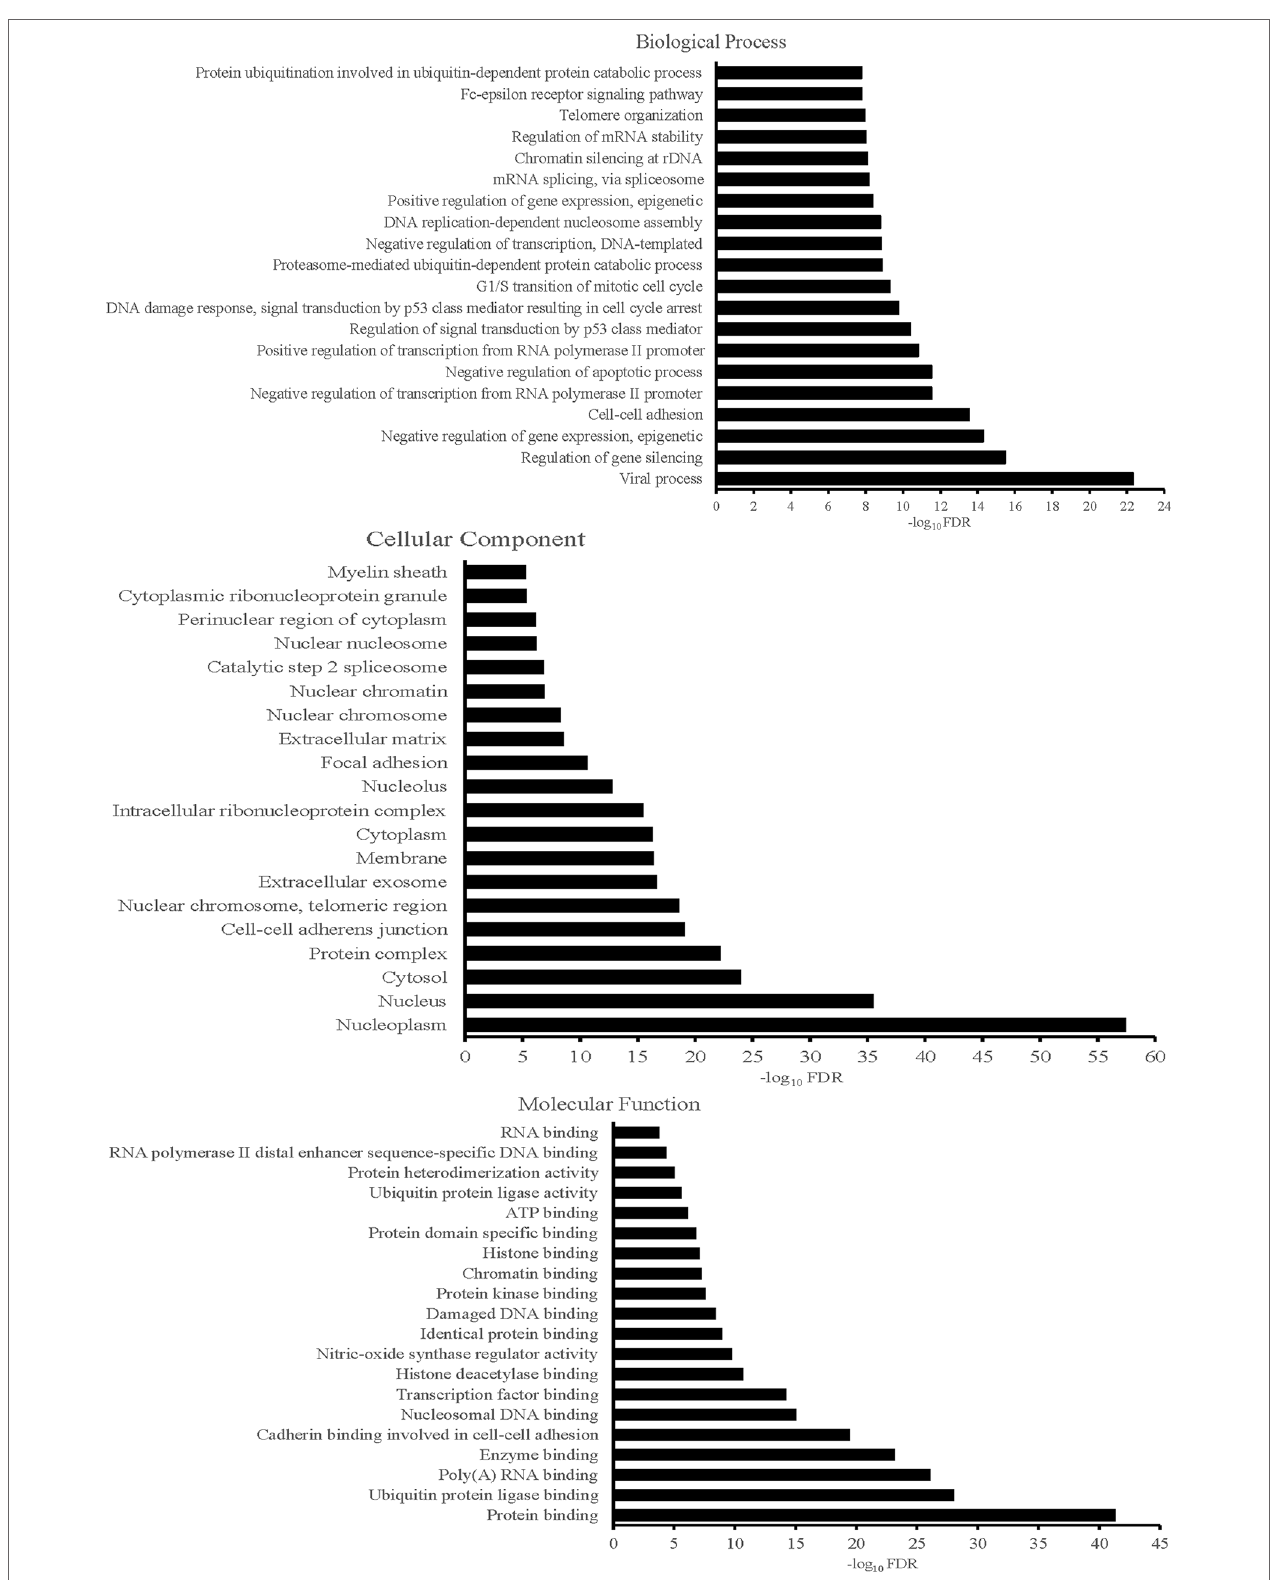
FIgUrE 4 | Gene ontology terms of candidate targets of YQSX against ITP. The top 20 GO functional categories with FDR < 0.05 were selected.